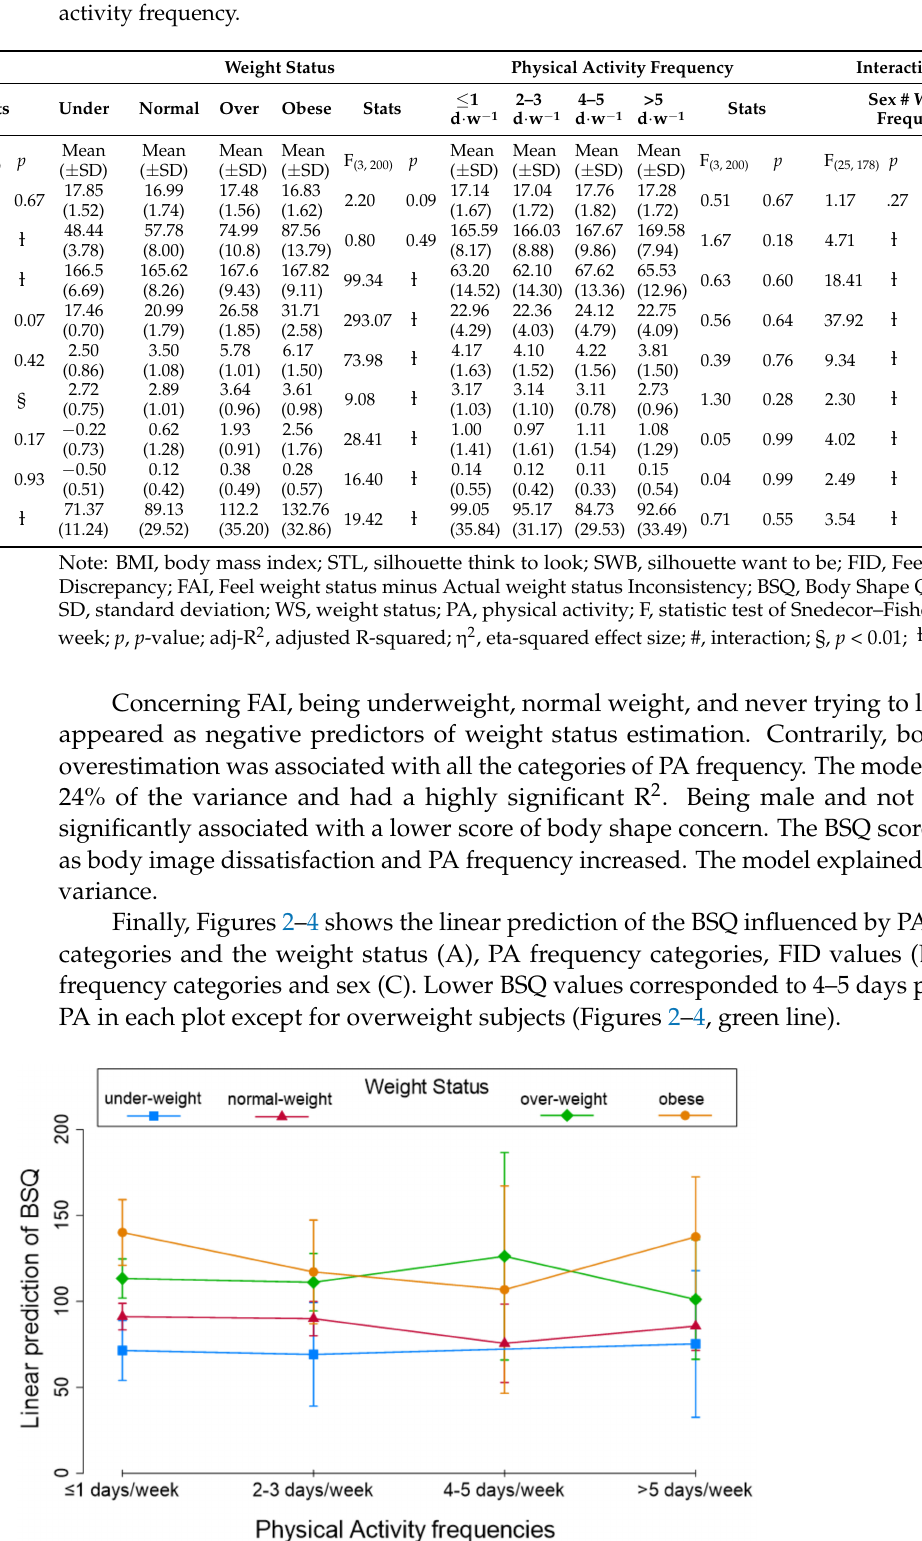
Table 2. Mean comparisons and interaction effects between sex, weight status, and physical activity frequency.